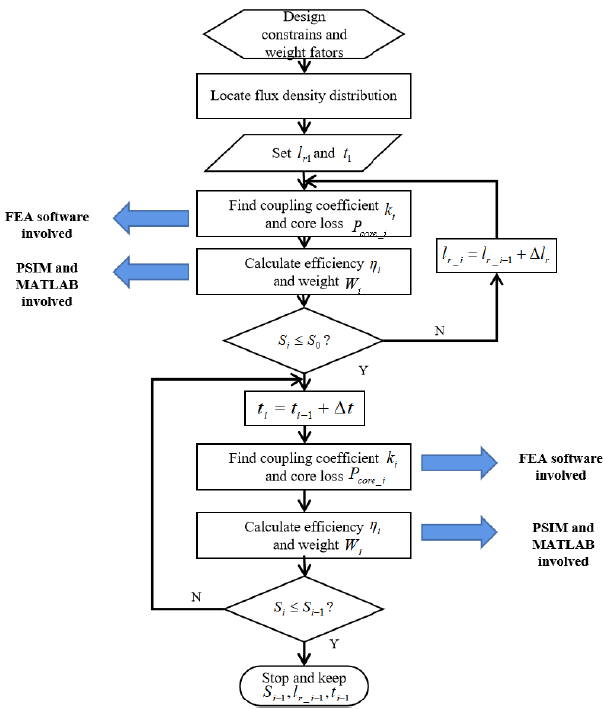
Figure 11. Iterative flowchart of optimization.